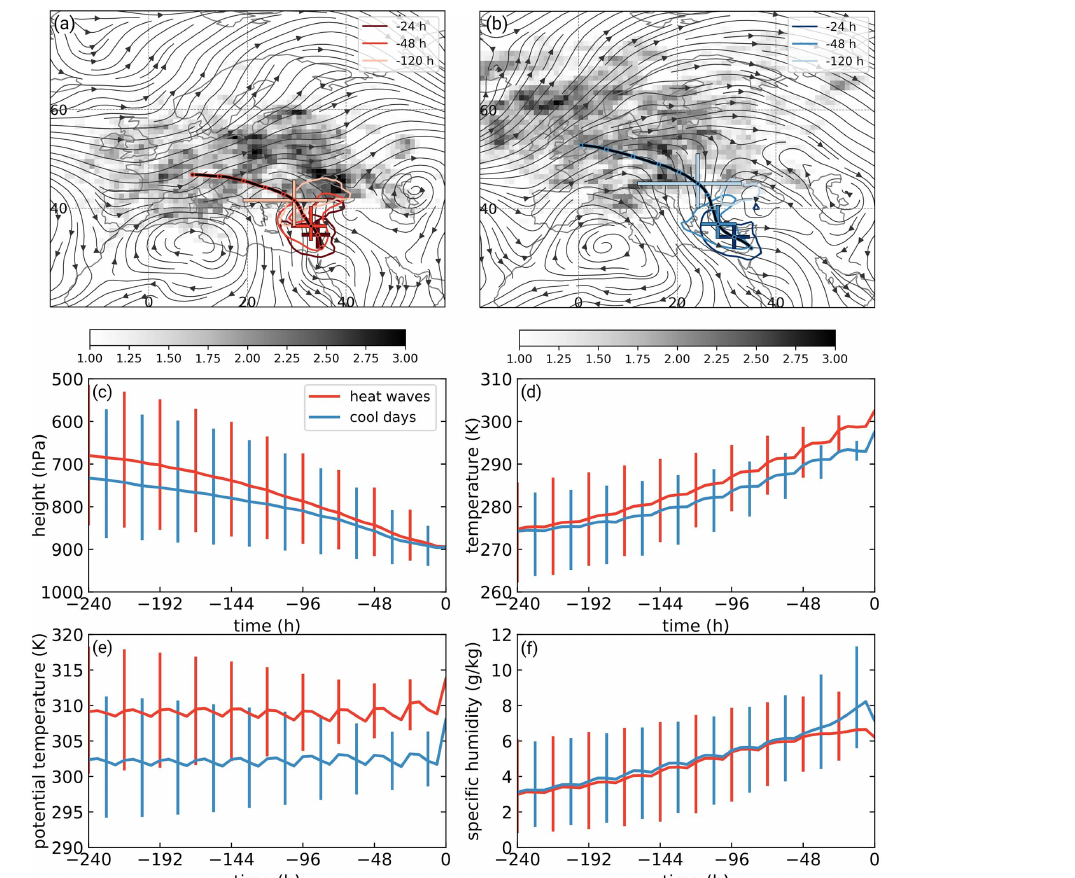
Figure 2. Median backward trajectory for (a) heat waves (upper 10% of CSI) and (b) cool days (lower 10% of CSI), with circles indicating days (from 10d before onset to onset). Gray shading shows the trajectory density 10d before onset (number of trajectories per 1000km 2 ), and contours show the trajectory density for the indicated time lags (5, 2 and 1d before onset; contours denote a density of 20 trajectories per 1000km 2 ). Streamlines of 800hPa winds averaged between − 5 and − 1d are included. The interquartile range of the trajectory positions is shown using crosses for the different time lags. The median evolution of (c) pressure (hPa), (d) temperature (K), (e) potential temperature (K) and (f) specific humidity (gkg − 1 ) of air parcels is also shown. Heat waves are indicated in red, and cool days are shown in blue. The interquartile range is plotted for the physical properties of the air parcels. A value of 0h corresponds to the first day of CSI ≥ 90% or CSI ≤ 10% and at